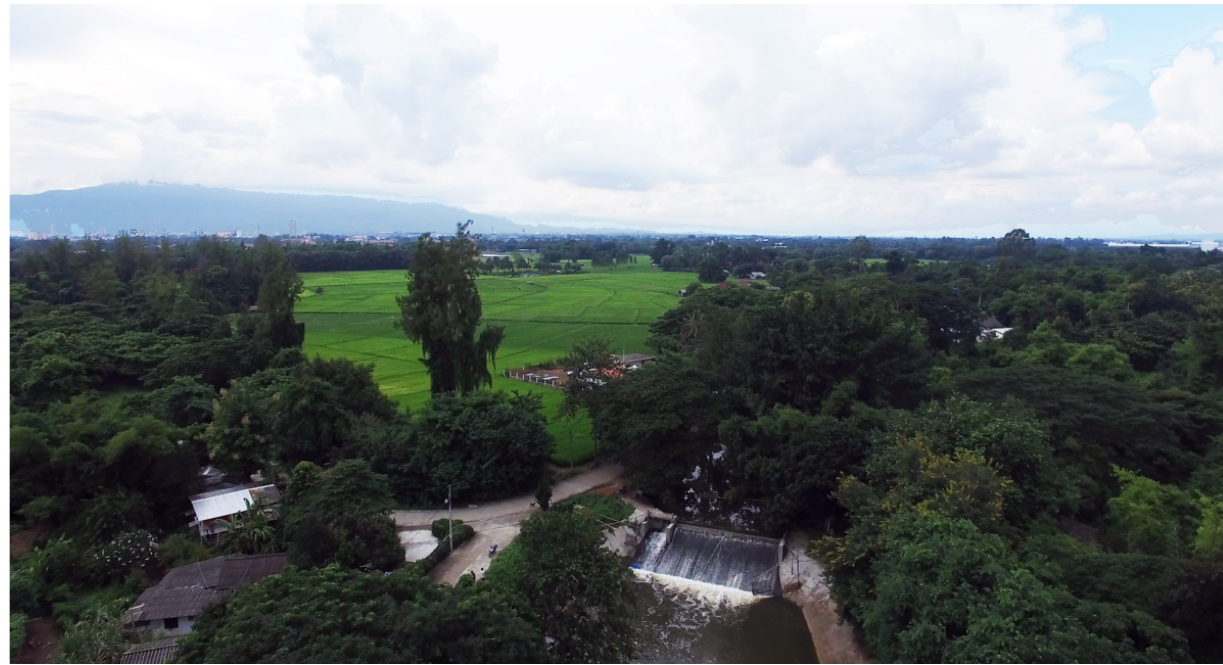
Figure 12. Royal irrigation department people’s irrigation project on site of former muang fai looking north with Doi Suthep mountain to the west (left of frame). The weir creates a fish hatchery pond upstream and feeds an irrigation canal following the curving road to the left. The large rice field in the background, fed by the upstream pond. The rice field is within the low-density housing zone as it is east of the Kuang River. The land to the west is zoned for agricultural preservation. Drone imagery: Santipab Sonboom, October